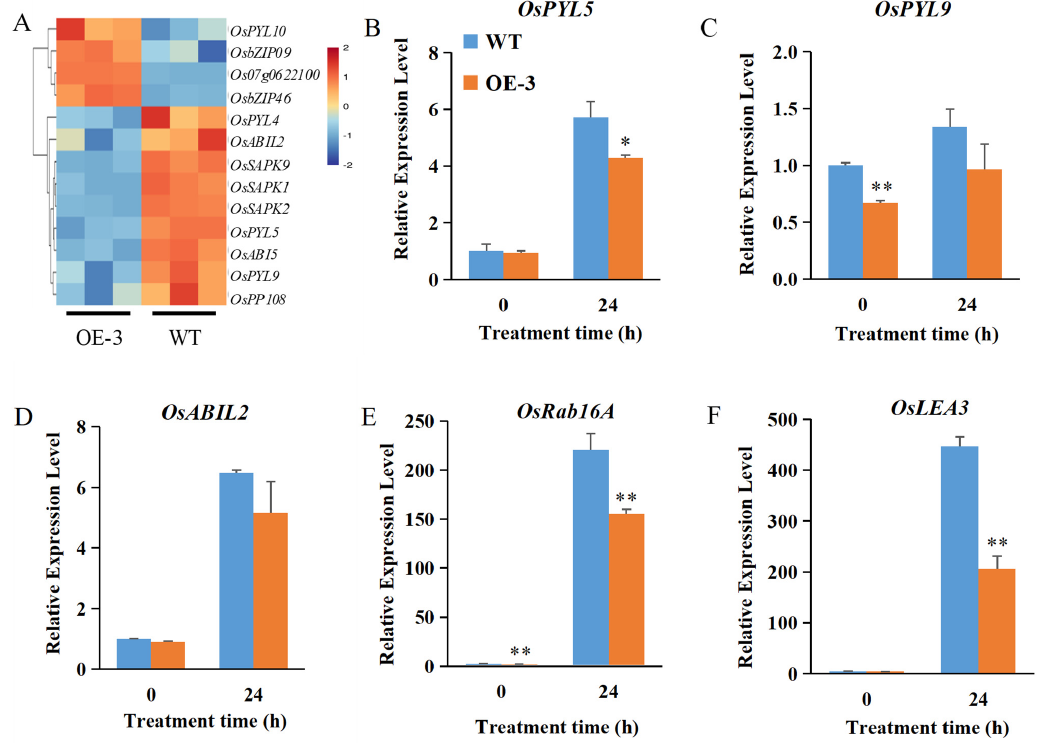
Figure 6. OsABT negatively regulates ABA signal transduction pathway. ( A ) Cluster analysis of differentially expressed genes (DEGs) in ABA signal transduction between OE–3 and WT at 24 h of salt treatment. Each column in the figure represents a sample, and each row represents a gene. Log2 processing was performed on the fragments per kilobase of exon per million mapped fragments (FPKM) value of these DEGs. ( B – F ) Root expression levels of ABA–related genes in 2–week–old OsABT–OE line (OE–3) and WT plants. Root RNA was isolated and used for qRT–PCR. Actin was used as an internal control. The relative expression levels were represented by fold change relative to the WT expression levels before salt treatment (0 h). Data are means ± SD of three independent experiments. Asterisks indicate significant differences compared to WT at * p < 0.05 and ** p < 0.01 (Student’s t